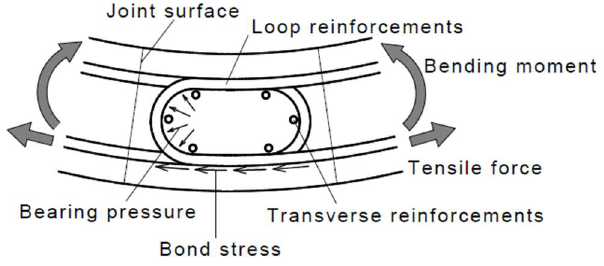
Figure 2. Force transfer of loop joint.